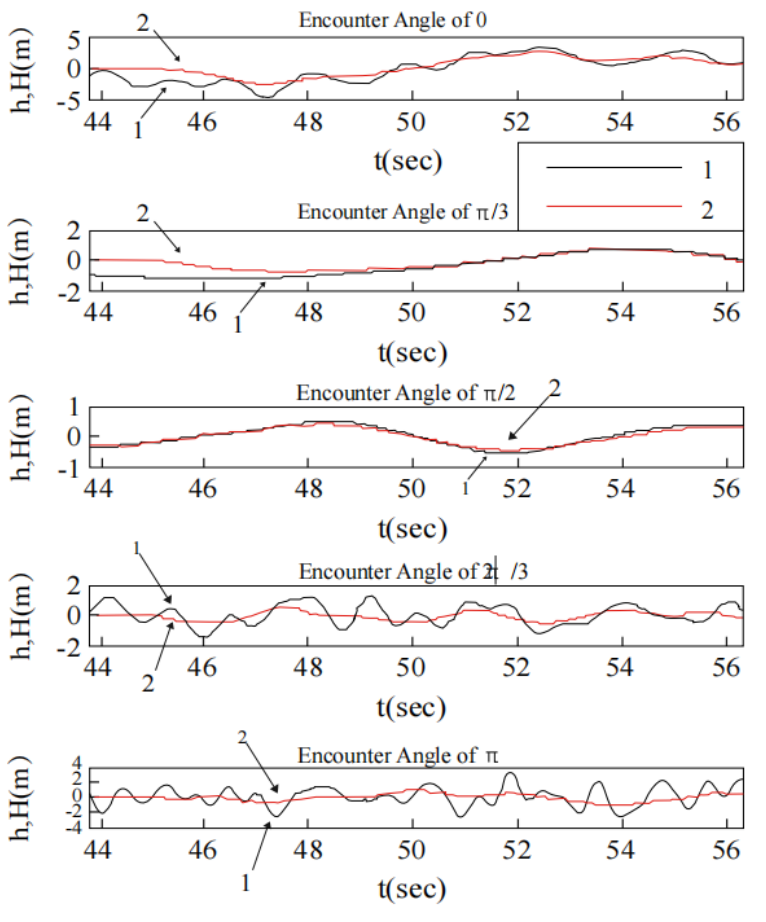
Figure 17. The response curves of carrier aircraft tracking the vertical motion of ideal landing point under different encounter angles.